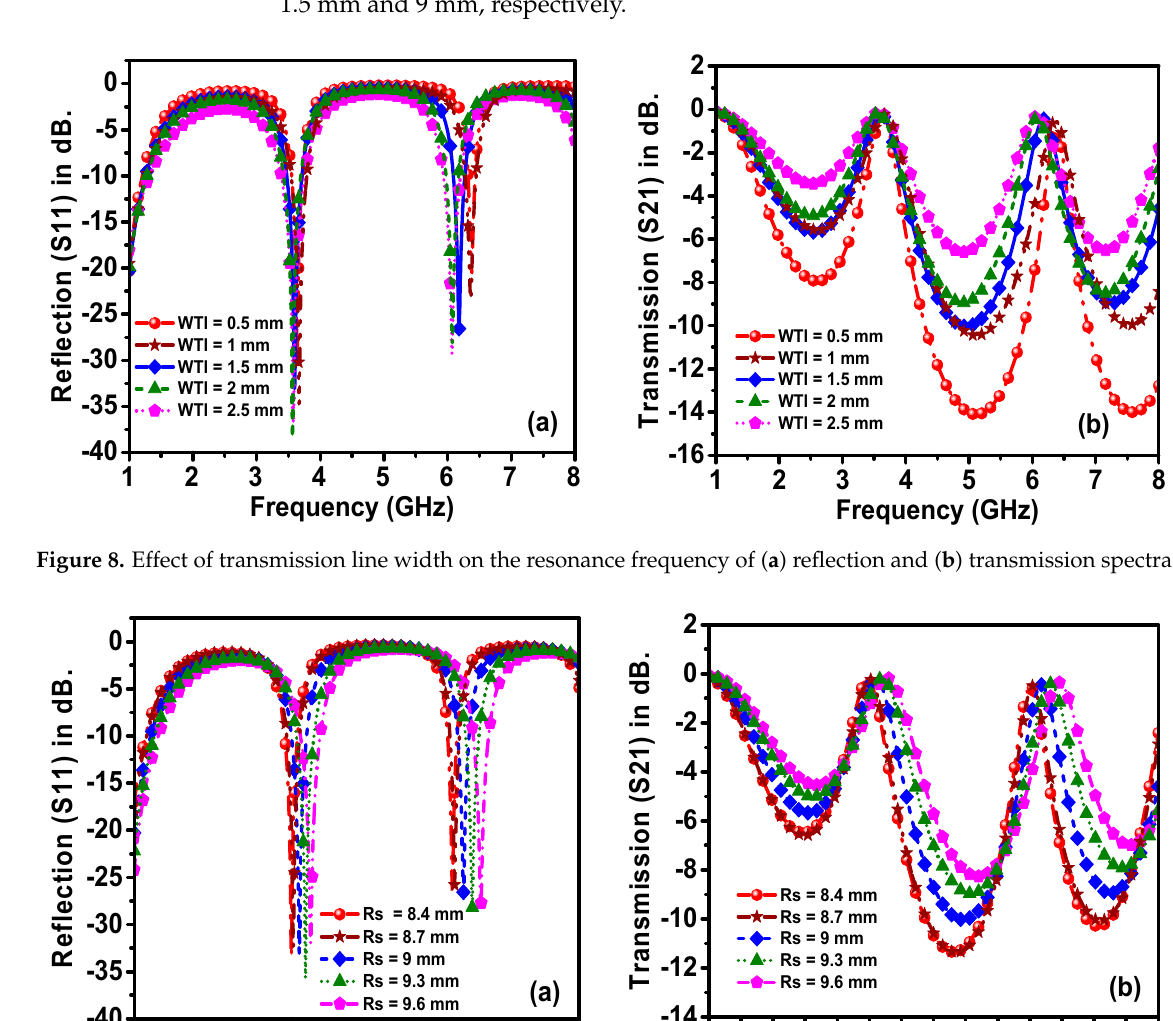
The measurements were run seven times sequentially and the average of the meas-